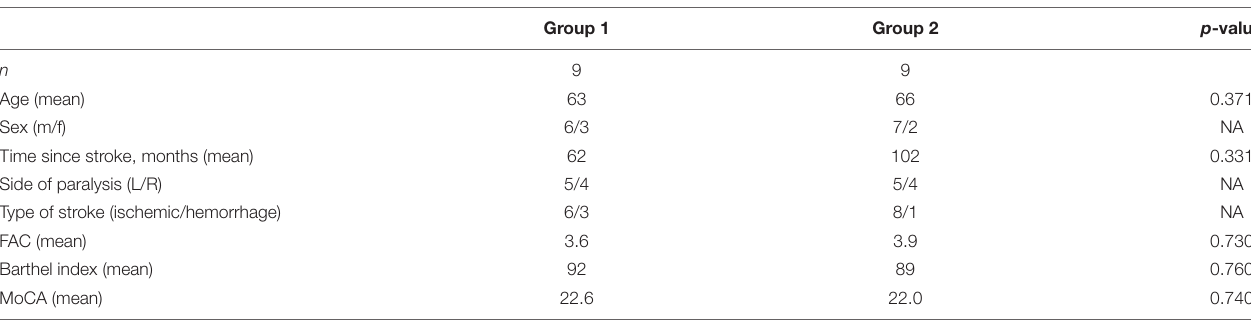
TABLE 2 | Demographic and clinical characteristics of the groups. Group 1 Group 2 p